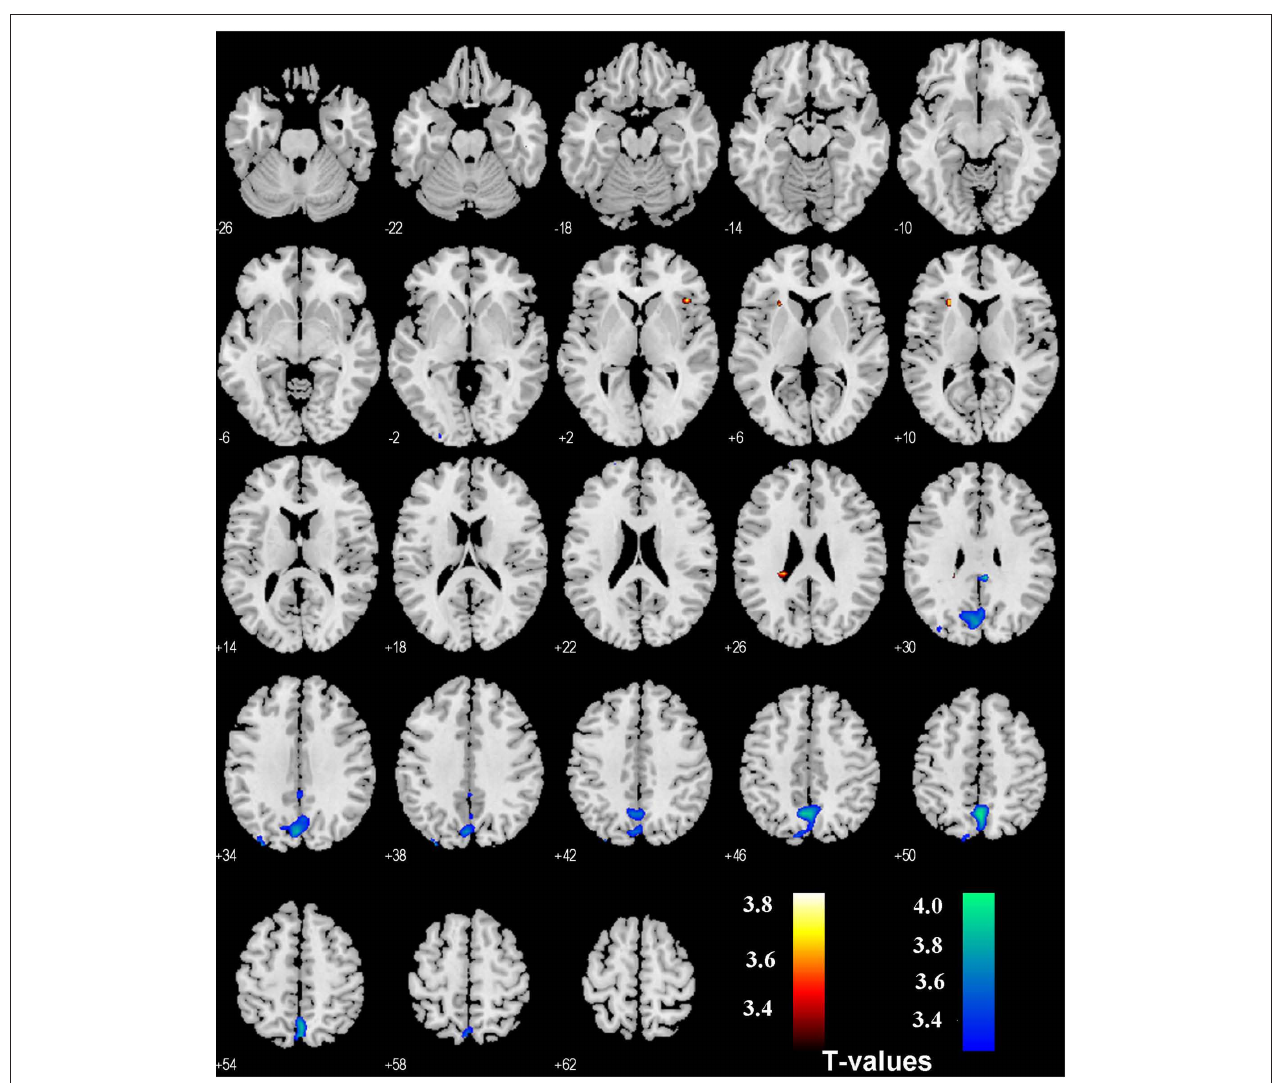
FIgure 3 | regions showing psychophysiological interaction with the habenula during stop error (Se) as compared to go success (g, in hot color), and during g > Se (in cold color) in the stop signal task. T maps were thresholded at p < 0.001, uncorrected.